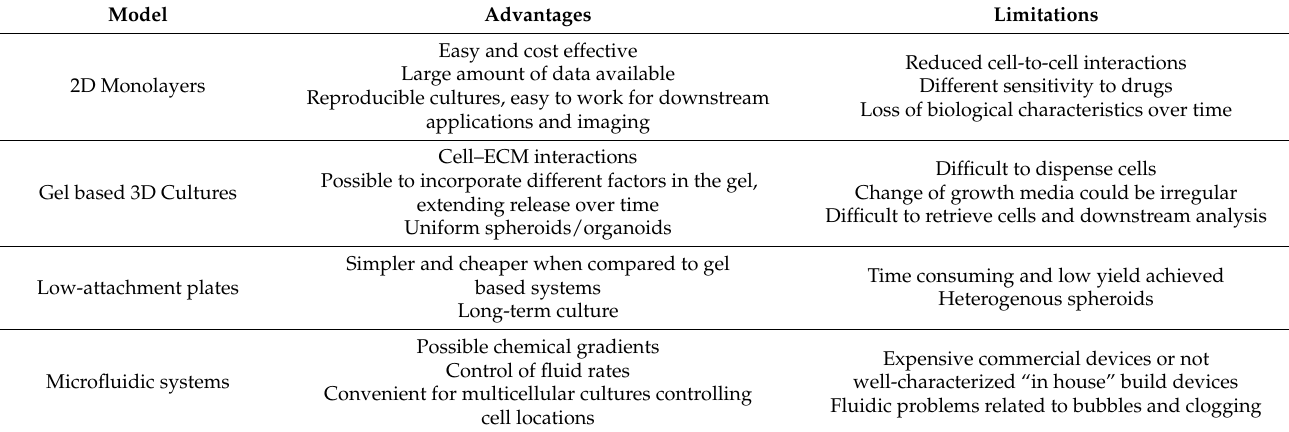
Table 1. Main advantages and limitations of the different cellular models in cancer research [13,14].